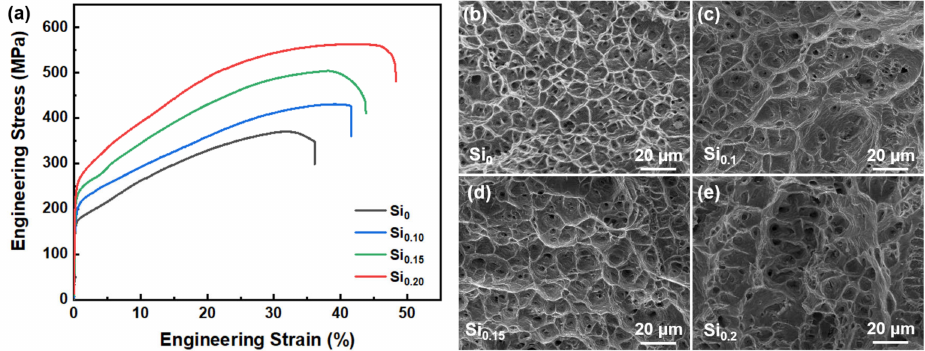
Figure 3. ( a ) Room-temperature tensile engineering stress-strain curves of the as-cast Si x MEAs. The fracture surfaces of the as-cast ( b ) Si 0 , ( c ) Si 0.1 , ( d ) Si 0.15 , and ( e ) Si 0.2 MEAs, respectively.